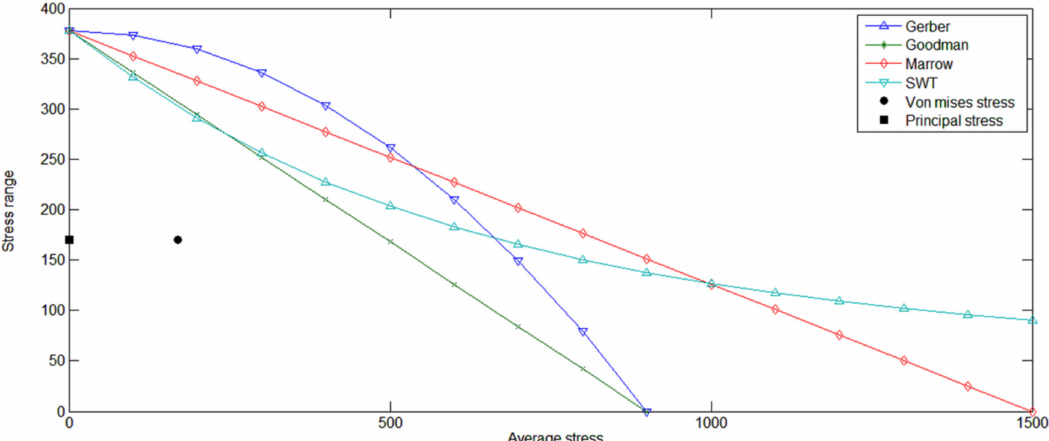
Figure 12. Average stress and stress range in the implant compared to the theories computed by taking a constant life of N f = 10 6 .